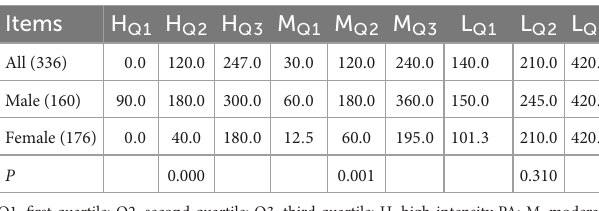
TABLE 2 Physical activity (PA) of college